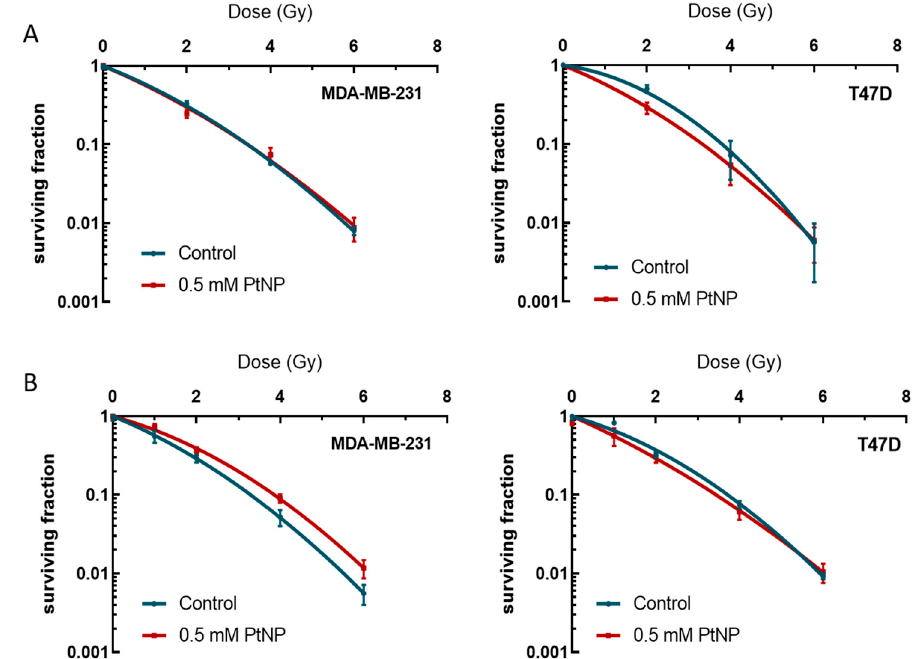
Figure 2. Survival of MDA-MB-231 and T47D cells, as determined by clonogenic assays. The surviving fractions of each cell line and each condition were plotted against the radiation dose. ( A ) Cells were exposed to 0.5 mM PtNPs for 6 h; irradiated at 2, 4, or 6 Gy; and cultured for 14 days (MDA-MB-231, 5 replicates) or 28 days (T47D, two independent sets of 5 replicates). ( B ) Cells were exposed to 0.5 mM PtNPs for 24 h; irradiated at 1, 2, 4, or 6 Gy; and cultured for 14 days (MDA-MB-231, 5 replicates) or 28 days (T47D, 5 replicates).